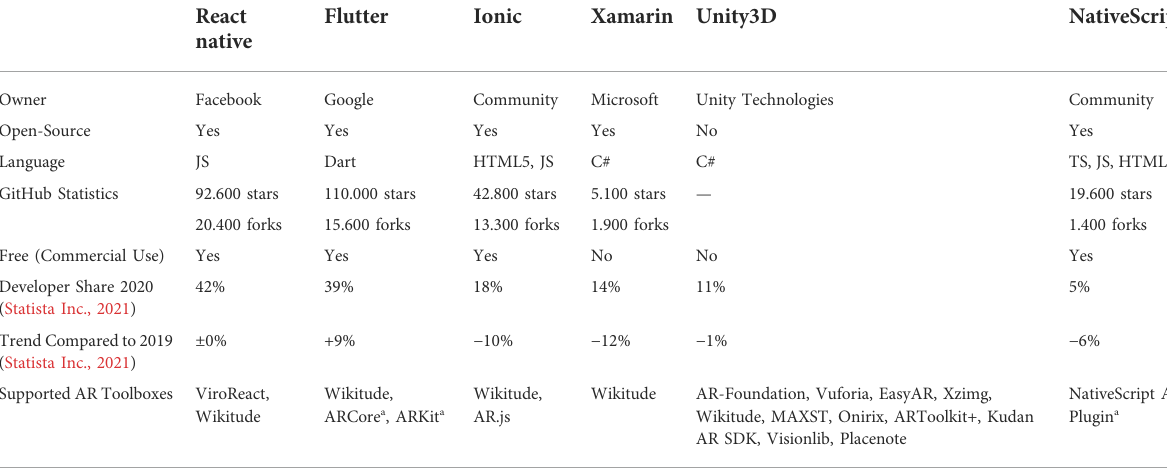
TABLE 2 Comparison of commonly used cross-platform app development